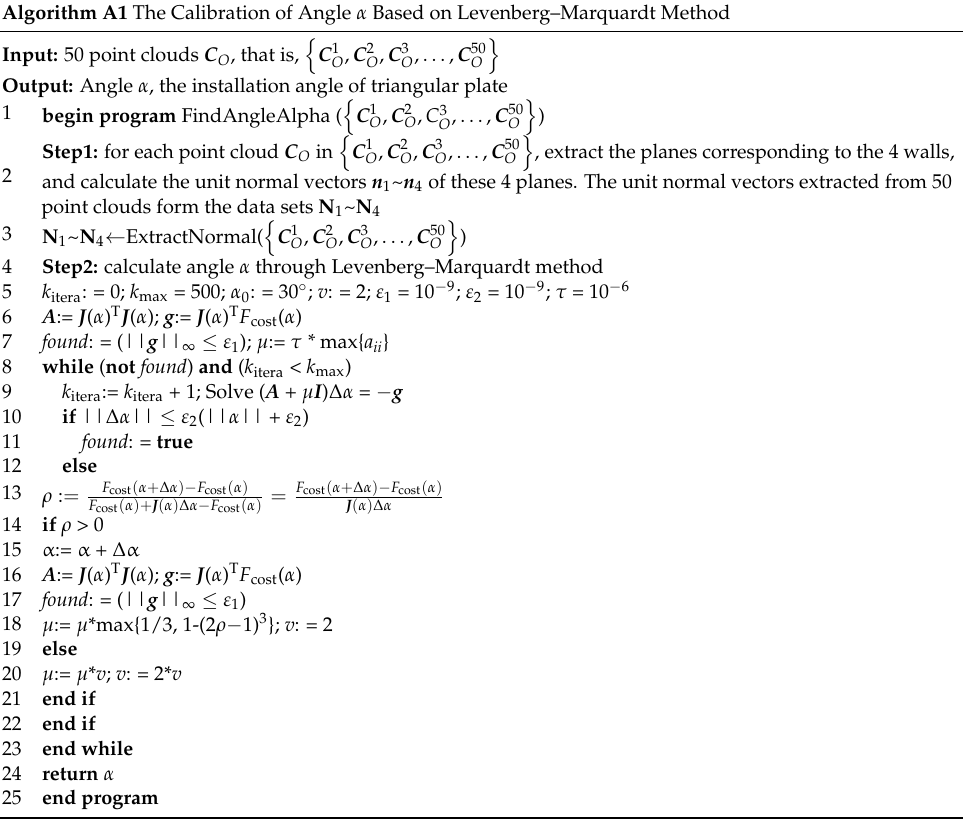
Algorithm A1 The Calibration of Angle α Based on Levenberg–Marquardt Method